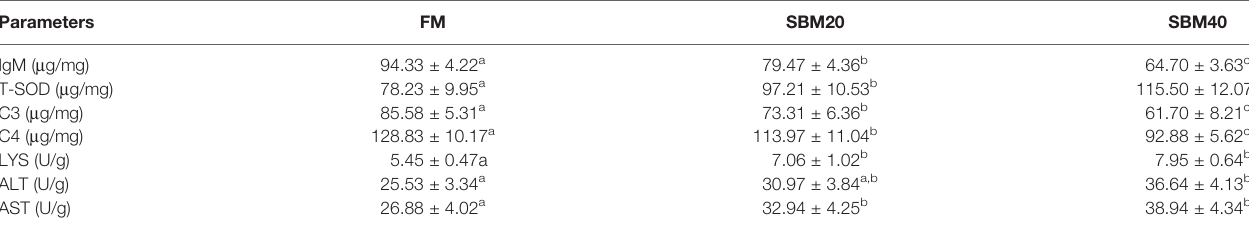
TABLE 4 | Effect of soybean meal on the enzyme activities of pearl gentian grouper ( n = 4).